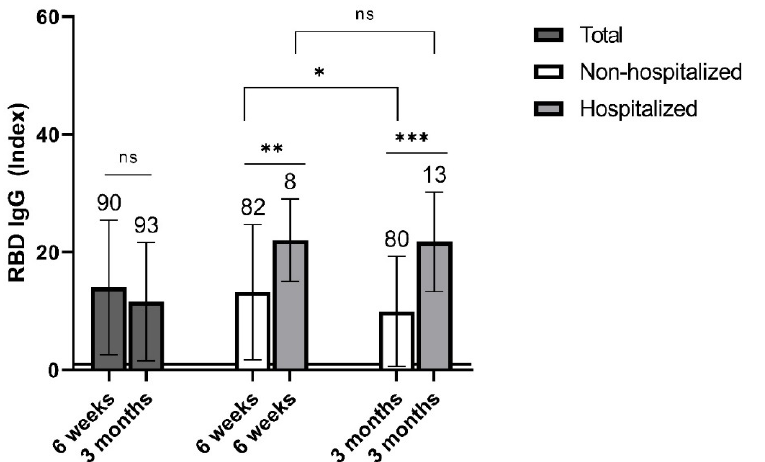
Figure 1. Mean levels of specific RBD IgG antibodies for individuals with past COVID-19 at 6 weeks and 3 months post infection. Results are presented for the whole group and according to hospitalization. Sample sizes are shown above standard deviation (SD) error bars. Horizontal line at an index of 1 indicates test cut-off. * p ≤ 0.05; ** p ≤ 0.01; *** p ≤ 0.001; ns—non ‐ significant.